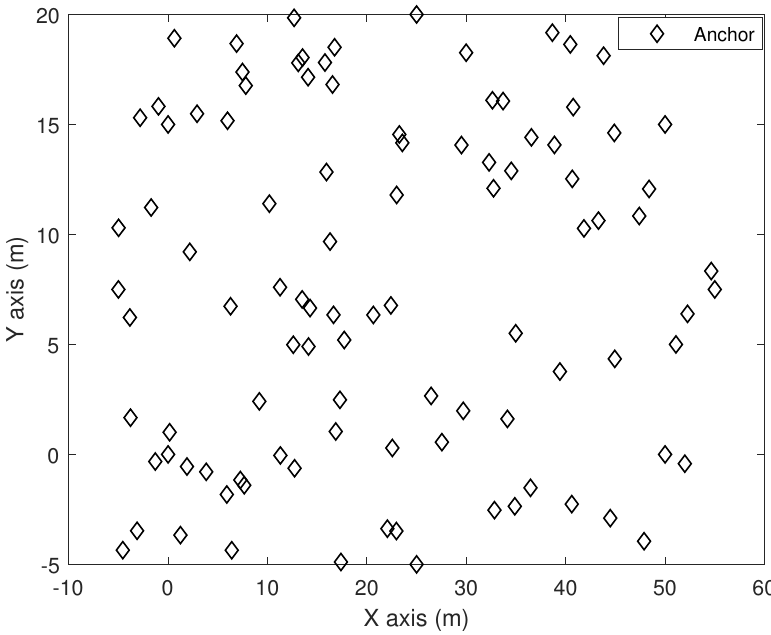
Figure 1. Coordinate positions of 100 anchor nodes in the experimental environment.